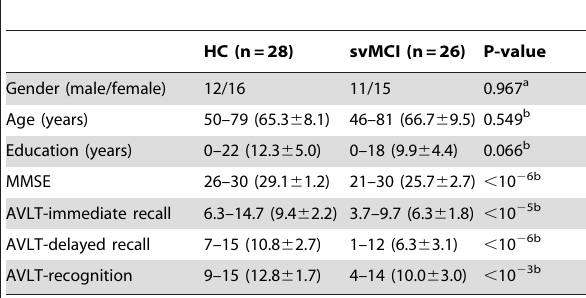
Table 1. Demographics and clinical characteristics of the